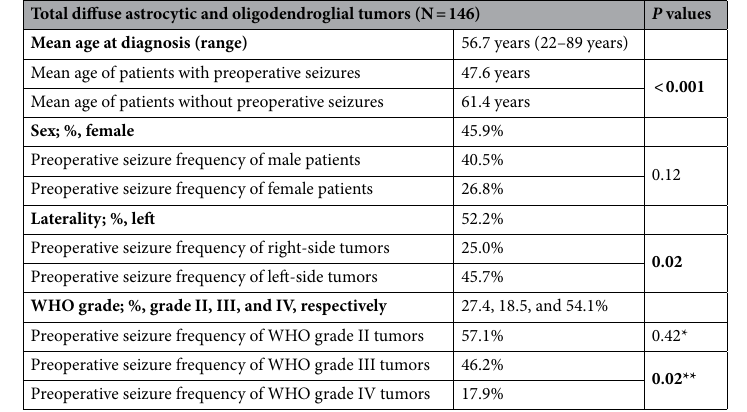
Table 1. Characteristics of patients with gliomas and the incidence of preoperative seizure. bold values indicate in p < 0.05 and consequently two analyzed categories were considered to be significantly different. IDH, isocitrate dehydrogenase ; WHO World Health Organization. *Comparison of preoperative seizure frequency between WHO grade II and III tumors. **Comparison of preoperative seizure frequency between WHO grade III and IV